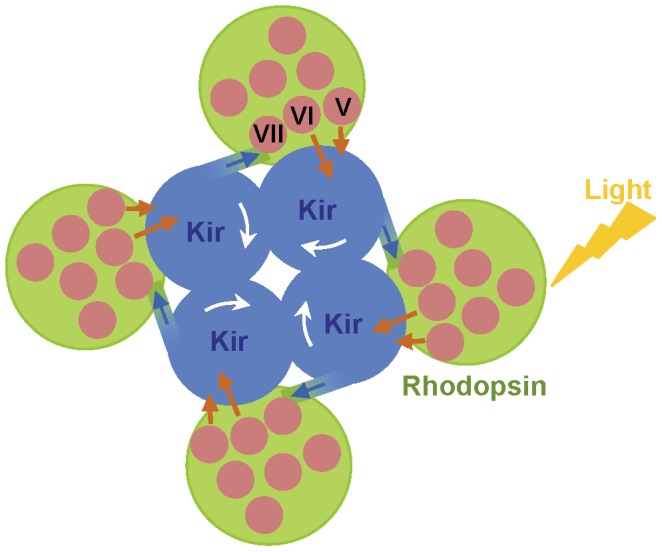
Possible mechanism linking channel gating to ligand binding.This sketch is a view of the opsin ICCR from the cytoplasmic side. The ICCR contains four Kir6.2 subunits (labeled Kir) that associate as a tetramer and four opsin receptors at the periphery. One hypothesis for the observed coupling between light activation of rhodopsin and channel gating could be that closing of the channel results from light-induced motion of receptor-channel linker (blue arrows) and rearrangement of opsin helices TM-V and TM-VI (brown arrows) (see text for details).